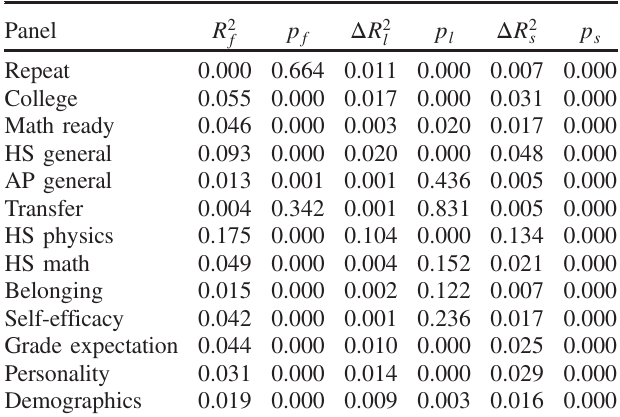
TABLE IV. Paneled variable importance. R 2 f represents the variance explained when all variables in the panel are the only variables in the model. Δ R 2 l represents the additional variance explained when all variables in the panel are added as the last variables in the model. Δ R 2 s is the average additional variance explained when adding the variables in the panel to a model subsampling the variable list to 5 variables. p f is the p value for the panel only model. p l is the p value for the ANOVA test comparing the two models. The p s value is the probability the difference Δ R 2 s happened by chance found using a t